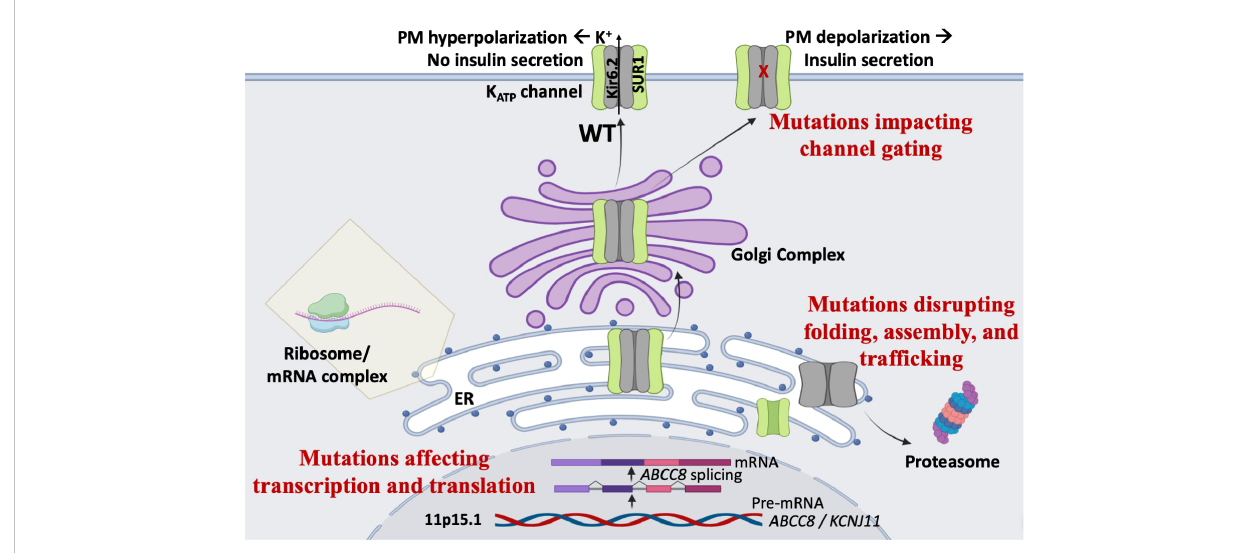
FIGURE 2 Mechanisms of K ATP -HI mutations. Mutations in the K ATP channel genes can lead to loss of channel function, persistent plasma membrane (PM) depolarization, and inappropriate insulin secretion via multiple mechanisms. First, mutations may impair gene transcription or protein translation. Second, mutations may disrupt K ATP channel protein folding, assembly, and traf fi cking, thereby compromising surface expression of the channel. Third, mutations may cause gating defects that prevent channel opening when blood glucose levels